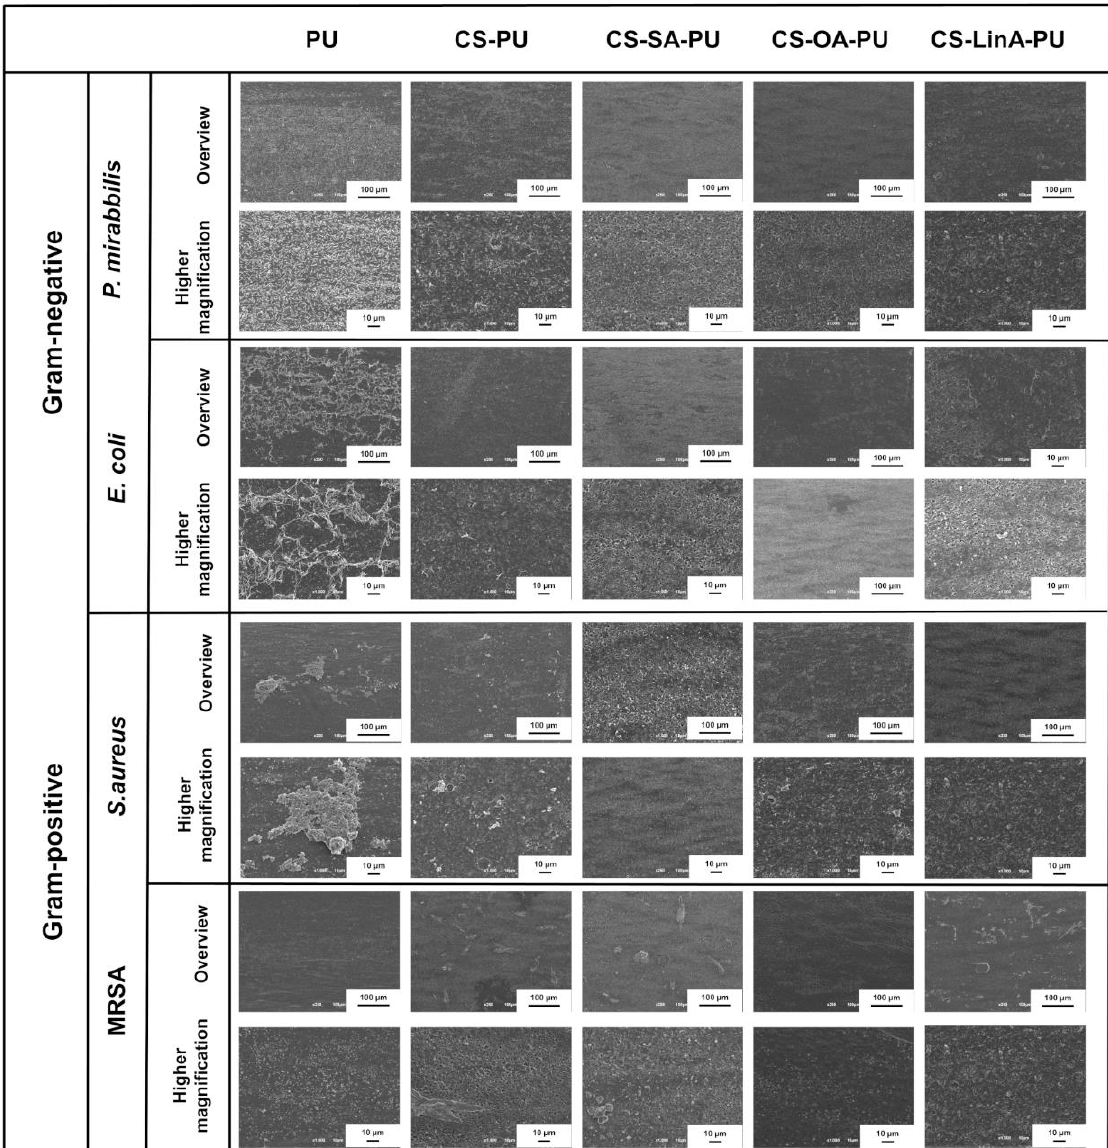
Figure 12. Representative SEM micrographs of P. mirabilis , E. coli , S. aureus and MRSA on the outer surface of control PU stents, CS-PU, CS-SA-PU, CS-OA-PU and CS-LinA-PU. Additionally, the viable bacteria adhering to the surface of CS and CS-FA derivatives- coated PU stents were further confirmed by analysis of confocal images following a Live/dead fluorescence assay against the selected microbial strains. Thus, the obtained